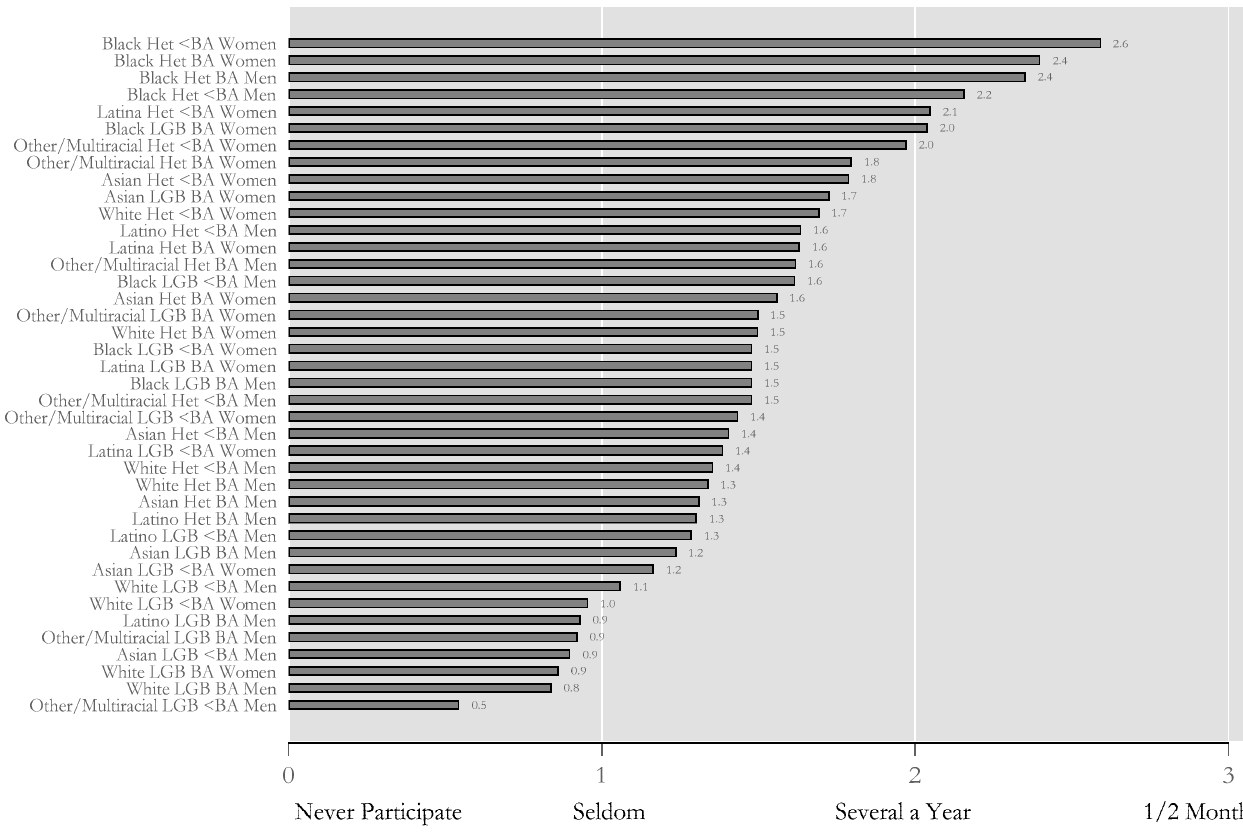
Figure A1. Religious small group participation (prayer groups, scripture study groups, etc.), RLS (N = 33,298).